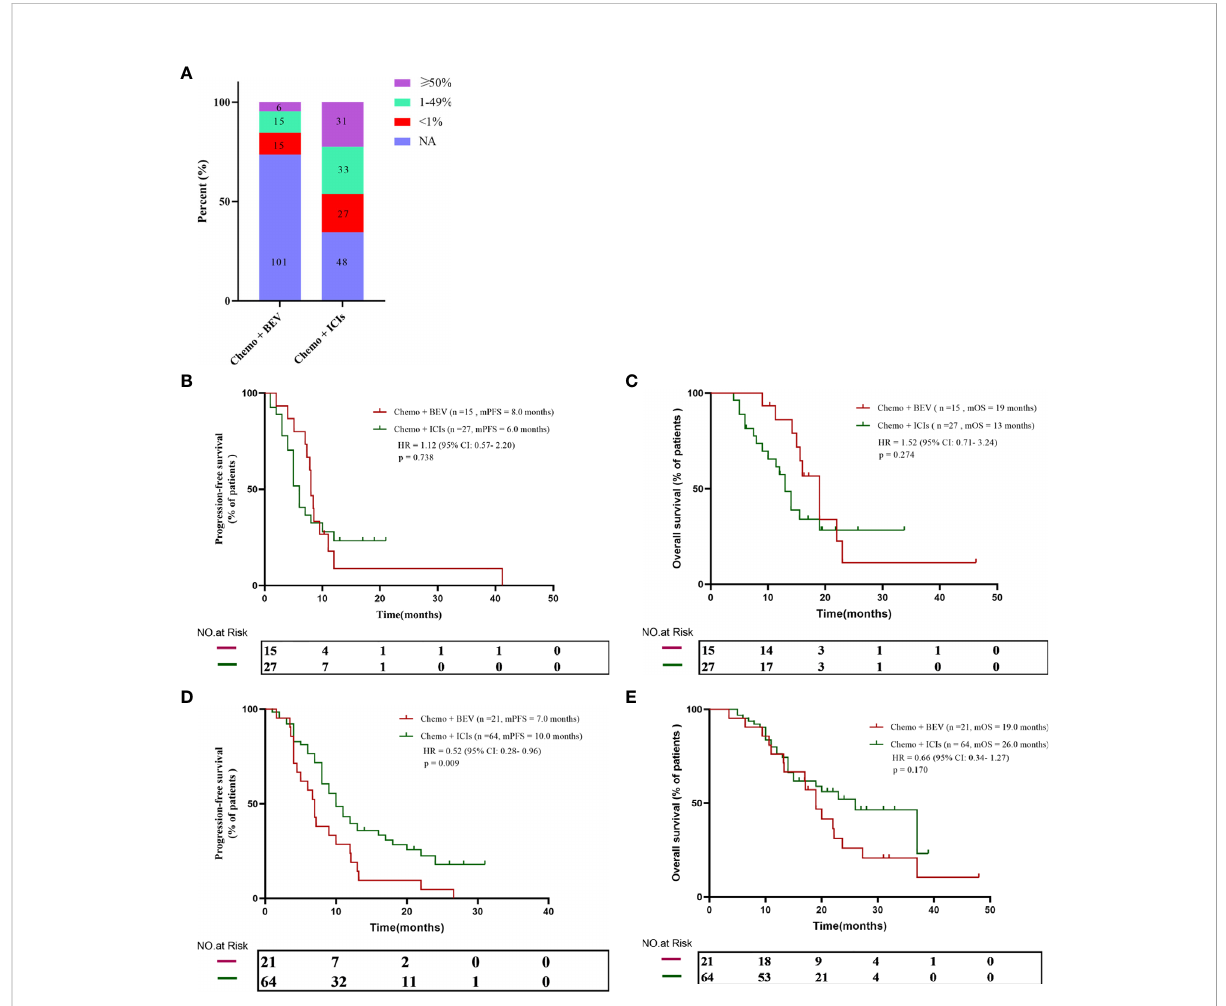
FIGURE 2 (A) PD-L1 expression in all patients. (B, C) The progression-free survival and overall survival curve of PD-L1 negative patients received chemotherapy plus either bevacizumab or ICIs. (D, E) The progression-free survival and overall survival curve of PD-L1 positive patients who received chemotherapy plus either bevacizumab or